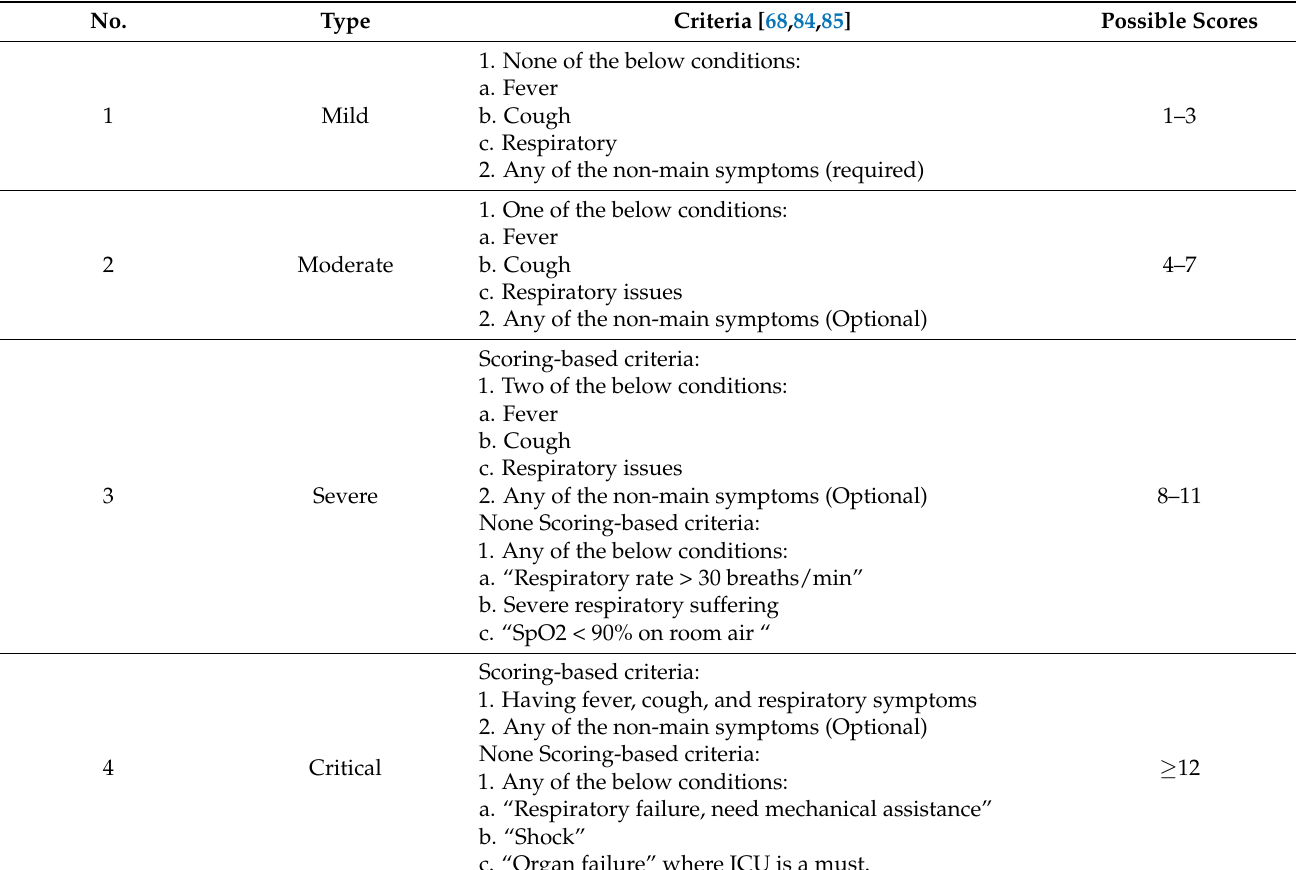
Table 10. Proposed severity level-based classification criteria for COVID-19 patients.